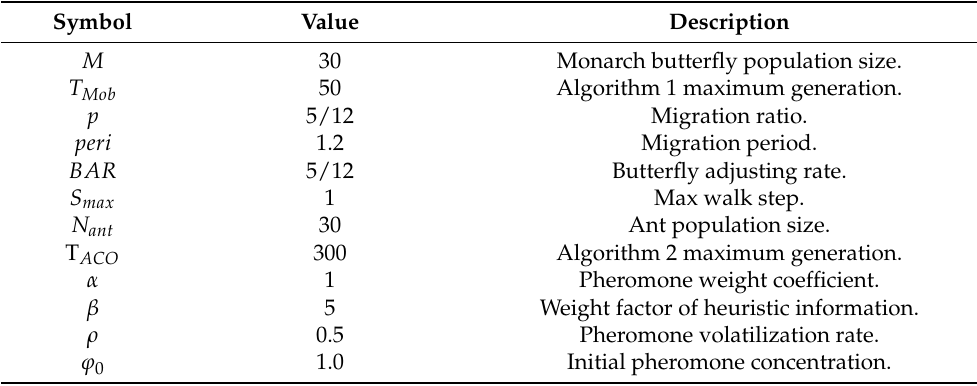
Table 2. Parameters set in Algorithm 1 and Algorithm 2.